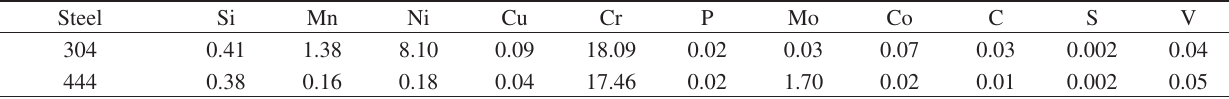
Table 3. Stainless steels chemical composition (%